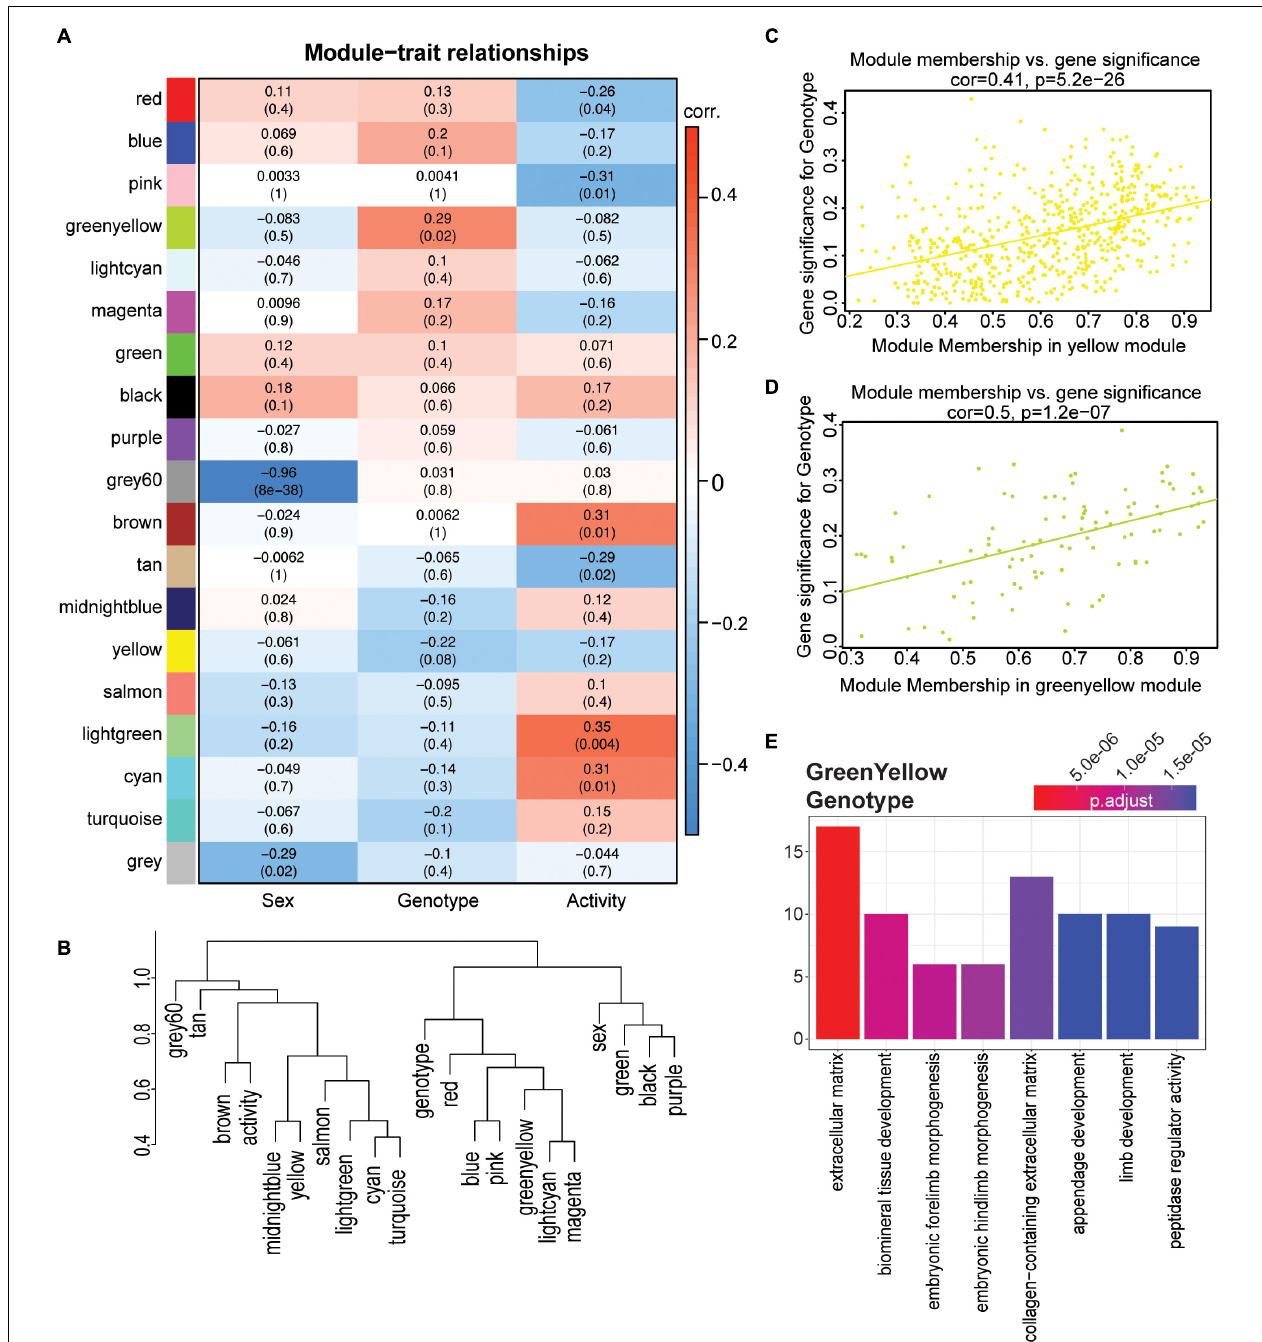
FIGURE 6 | WGCNA confirmed functional enrichment of GO terms relating to extracellular matrix and morphogenesis is affected by APOE genotype. (A) Heatmap of module correlation and FDR values for sex, APOE genotype, and activity ( p < 0.10). (B) Eigengene dendrogram of each module and sex, APOE genotype and activity. Y axis is a measure of dissimilarity. (C,D) Gene significance regressed against module membership to show correlation and significance for the yellow (C) and greenyellow (D) modules for APOE genotype. (E) Functional enrichment of the genes in the greenyellow module which is significant for APOE genotype ( p <